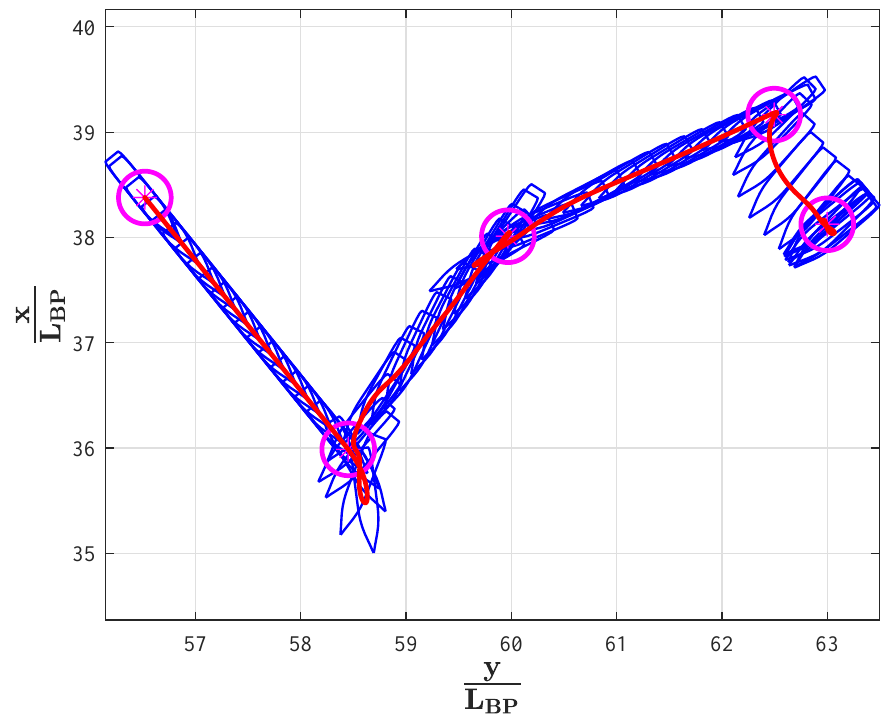
Figure 8. Low-speed actual path. Magenta markers are the waypoints and the circles are the tolerances and the red line is the vessel